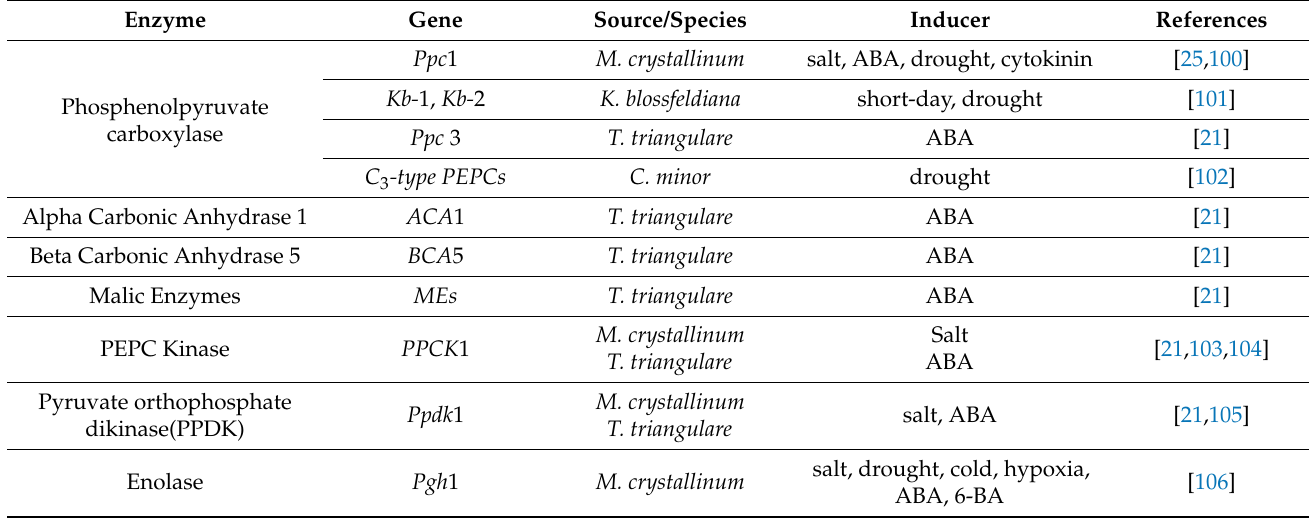
Table 1. Some enzymes and genes involved in some facultative CAM plants during the photosynthesis shift from C 3 to